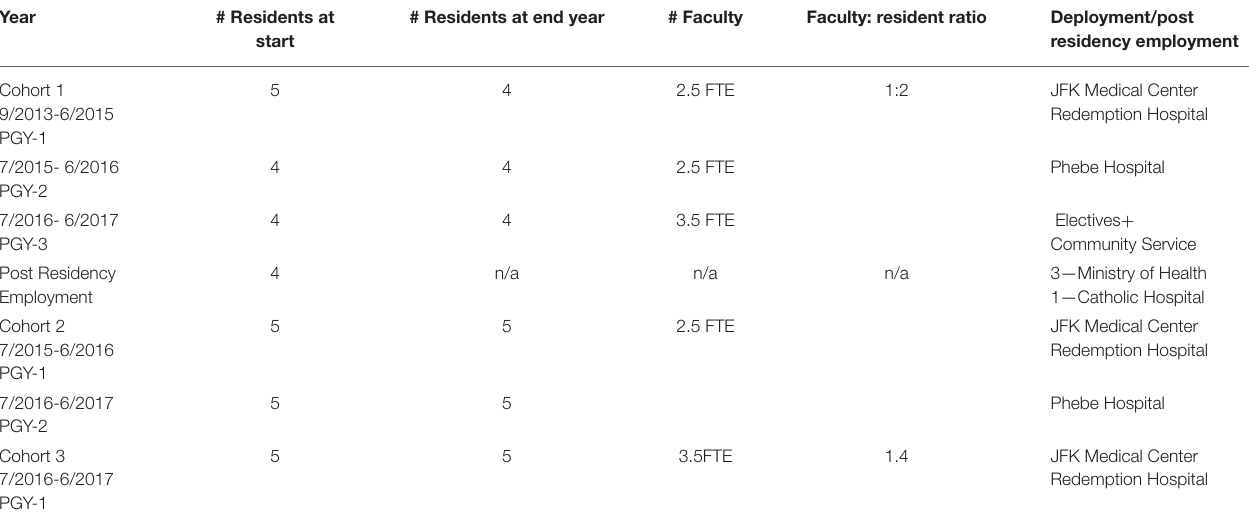
TABLE 3 | Post-graduate rotations/post residency